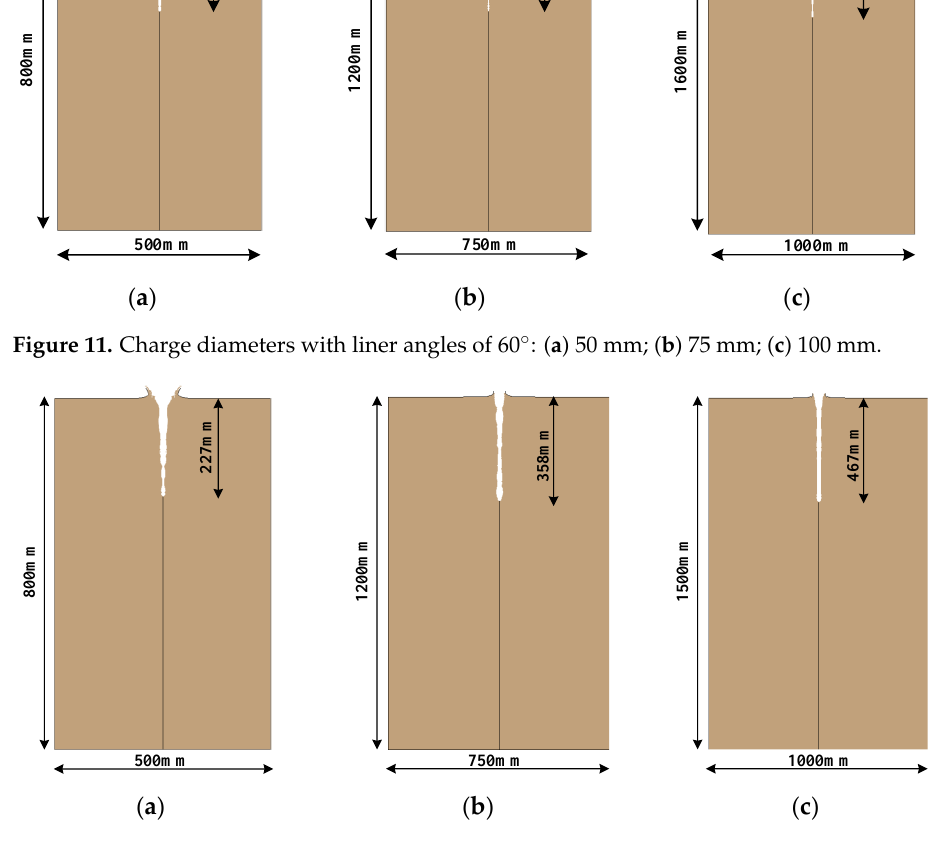
Figure 12. Charge diameters with liner angles of 90°: ( a ) 50 mm; ( b ) 75 mm; ( c ) 100 mm.